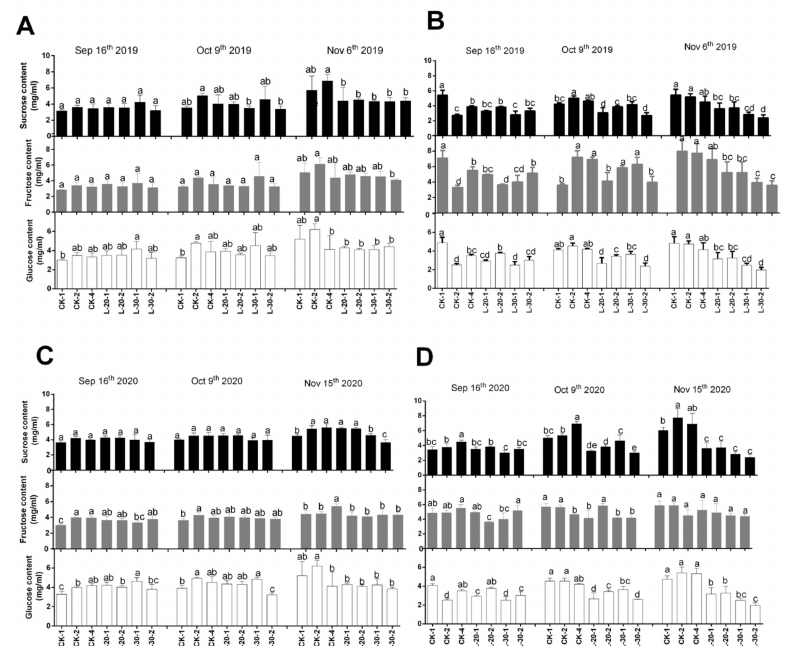
Figure 2. Comparison of changes of soluble sugar components and contents in peel ( A , C ) and flesh ( B , D ) under different fruit load treatments from the near-mature period (mid-September) to the fully-mature period (mid-November). Within columns, means with the different letter indicate significant differences ( p < 0.05) using Duncan’s test, bars on the columns represent the standard error of the mean ( n = 3).